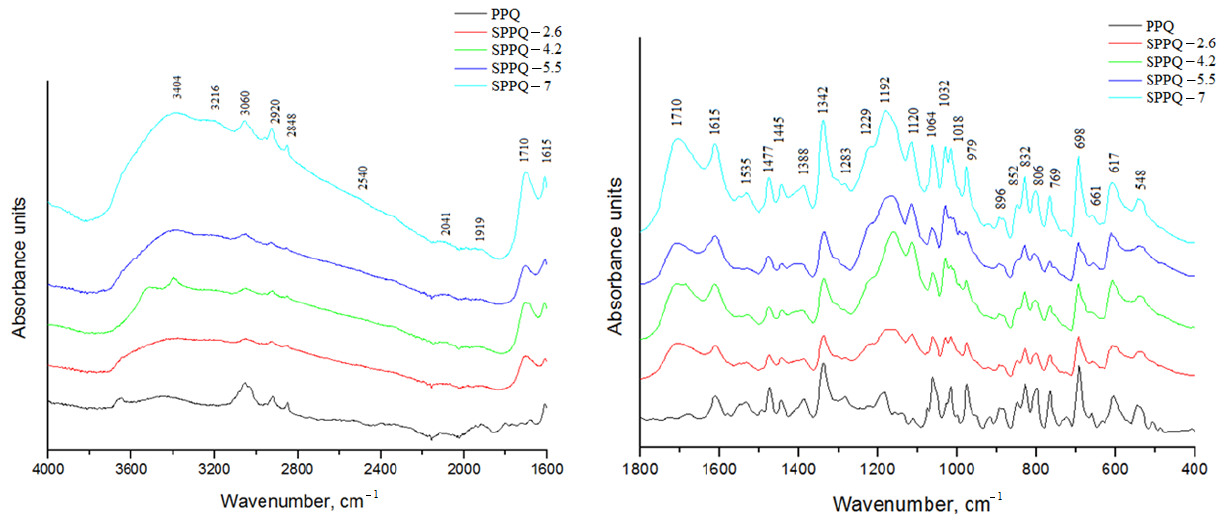
Figure 8. IR absorption spectra of PPQ and SPPQ with different amount of S, %. The PPQ film investigated by IR spectroscopy is anhydrous, as evidenced by the spectrum free of any absorption bands in the 3100–4000 с m − 1 region. Consider the over- view IR absorption spectrum of the SPPQ 5.5% film (Figure 8). It is noteworthy that, upon sulfonation of PPQ, the vibrational frequencies, and intensities of most of the bands, as a rule, do not change. This fact indicates that there is no violation of the conjugation of bonds in the heterocycle. Sulfonation leads to the appearance of an intense band at 1192 с m − 1 . High intensity and noticeable broadening of the contour, not to mention the value of the vibration frequency, are quite characteristic of the band of the antisymmetric stretching vibration ν as (SO 3 ) of the sulfogroup. A narrow band of average intensity at 1033 cm − 1 can be attributed in the first approximation to the symmetric stretching vibration of the ν s (SO 3 ) sulfogroup. There is a band of in-plane deformation vibrations of ССС and a band of in-plane bending vibrations of ССС with the participation of bond angles ССС are located nearby, as well as stretching vibrations of the ring. The maximum of the first of them is at 1019 cm − 1 , and the maximum of the second is at 1066 cm − 1 . Small differences in frequencies create favorable conditions for mixing all these vibrations. The bands of deformational antisymmetric and symmetric vibrations of the sul- fogroup are usually of low intensity. In the case of interest to us, these vibrations do not lead to the appearance of separate bands, partly for this reason and also due to mixing with out-of-plane vibrations of the CH bonds and the ring. However, the obvious en- hancement of the band at a frequency of 616 cm − 1 , which is observed on going from PPQ to SPPQ, can be caused by a noticeable contribution of the δ а s (SO 3 ) vibration. For the band of average intensity at 1699, 1715 cm − 1 refers to stretching vibrations of the C=O bond. It is absent in the spectrum of the PPQ film, which indicates the appearance of an impurity of one of the initial two reagents, namely tetraketone BFGB, in the sample under study upon sulfonation. In contrast, TADO tetramine bands are not detectable. It was found that the (CO) band of tetraketone disappears after the treatment of SPPQ with an aqueous solution of NaOH. The band at 3059 cm − 1 (shoulder 3016 cm − 1 ) has an average intensity and a narrow profile in the IR spectrum of the PPQ film. On the side of low frequencies from it, there are two much less intense and, at the same time, very narrow bands. The maximum of one of them is at 2917 cm − 1 , and the other at 2849 cm − 1 . It is obvious that all three bands are related to the stretching vibrations of CH bonds. A similar band with a narrow profile and a maximum at 3060 cm –1 is also present in the IR absorption spectrum of the SPPQ film. At the same time, sulfonation of the PPQ film leads to the appearance of an intense band